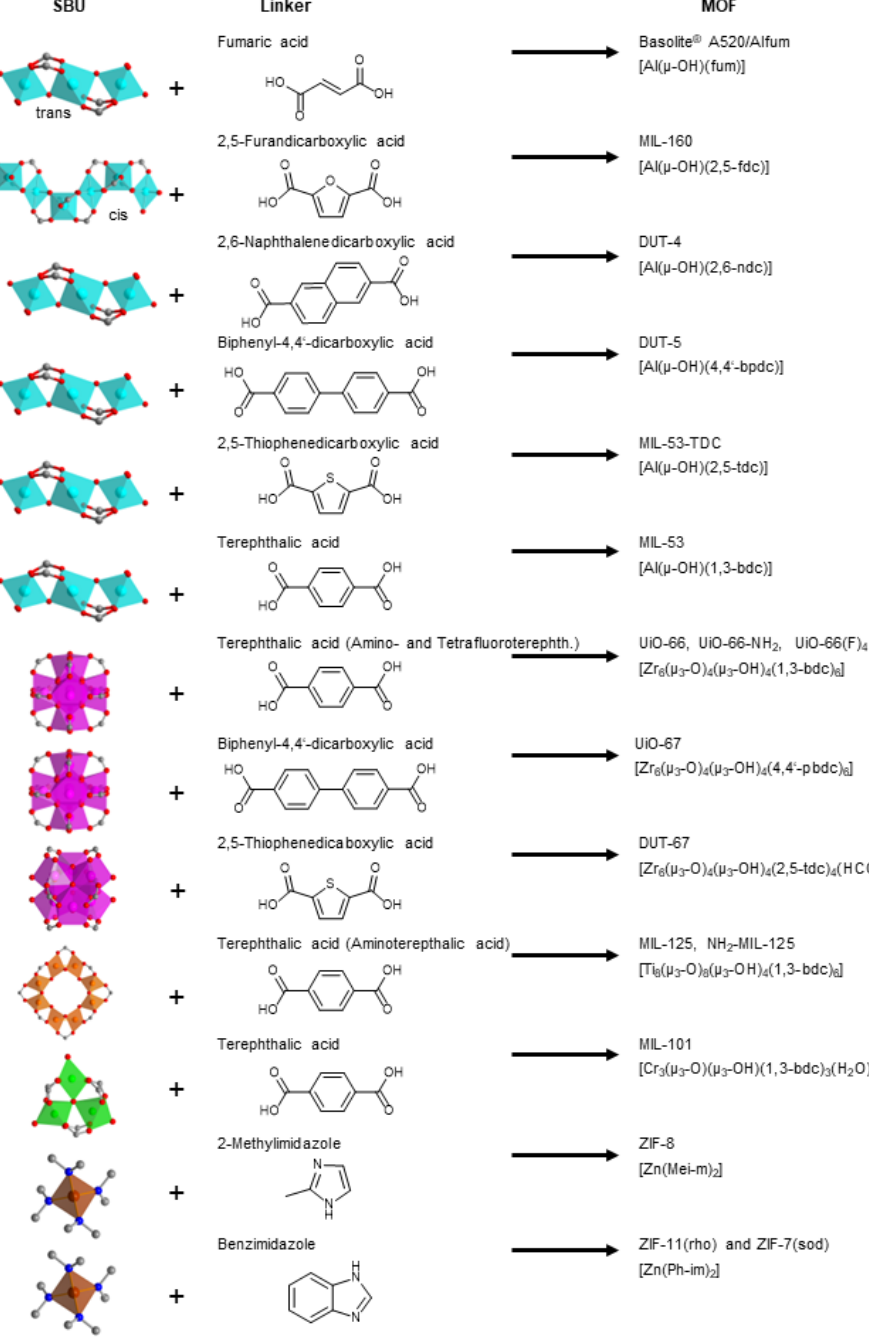
Figure 1. MOFs investigated here for C 6 -VOC adsorption. Secondary building units (SBUs) depict the metal atoms and their coordination polyhedra (Al cyan, Zr magenta, Ti orange, Cr green and Zn brown), which are connected via the linker (acid or imidazole form in the middle column) to form the respective MOFs (right column) (carbon gray, oxygen red, nitrogen blue). For further details to the MOFs see Section S2.